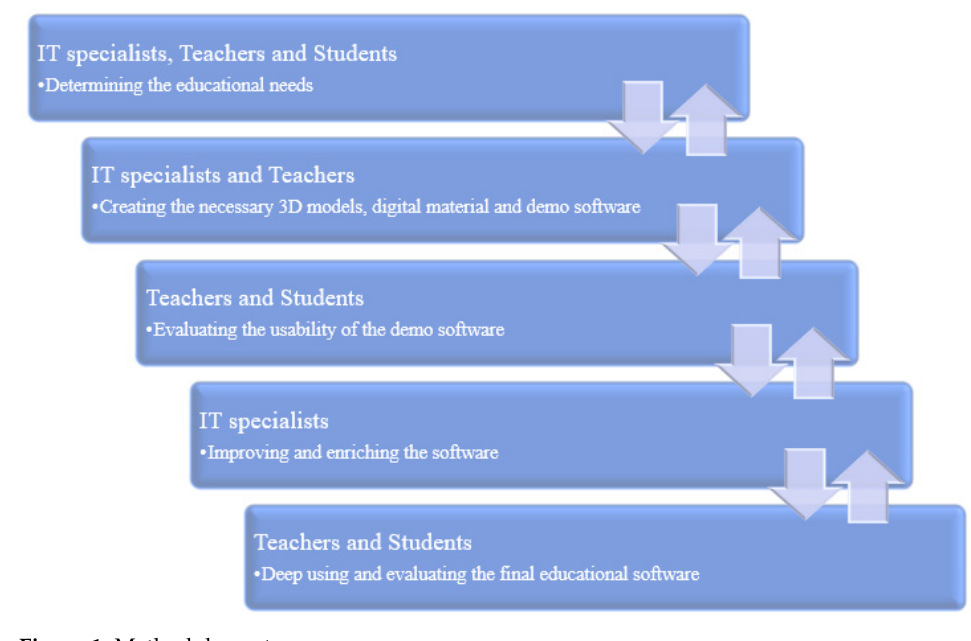
Figure 1. Methodology